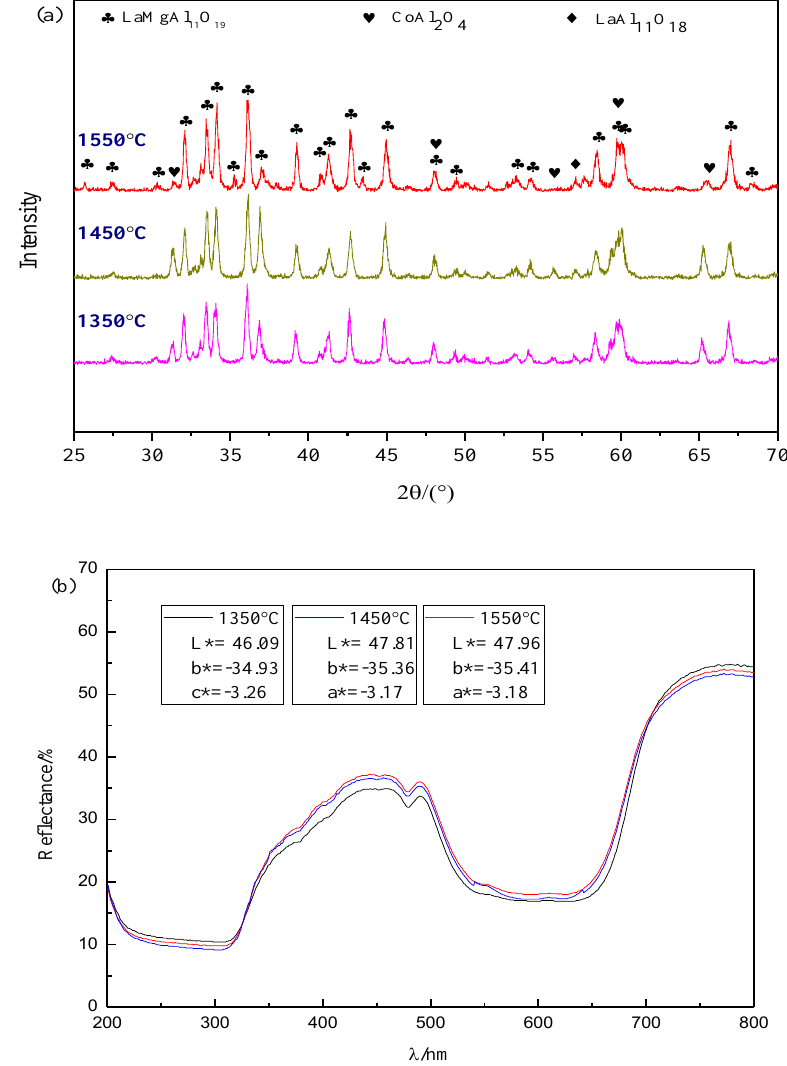
Figure 7. Effect of different temperatures on the performance of the best color sample (x = 1.0). ( a ) Effect of temperature on the phase of the sample. ( b ) Effect of temperature on the optical properties of the sample.